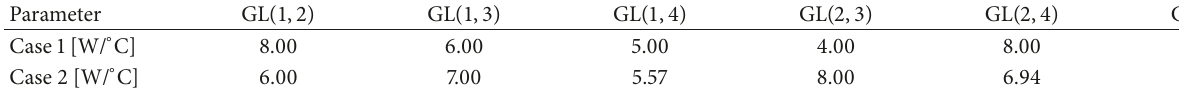
Table 8: GLs values for case 1 and case 2 [W/ ∘ C].